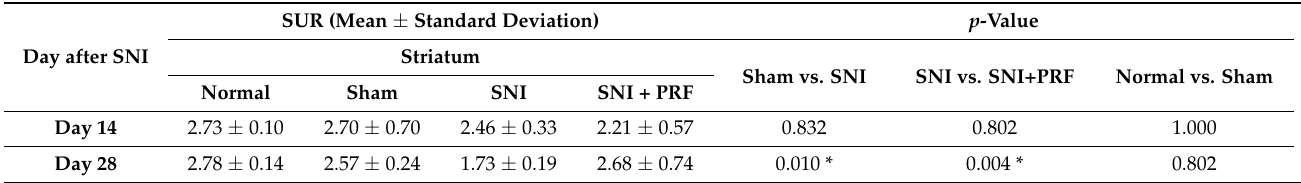
Table 2. SURs in striatum in each group.